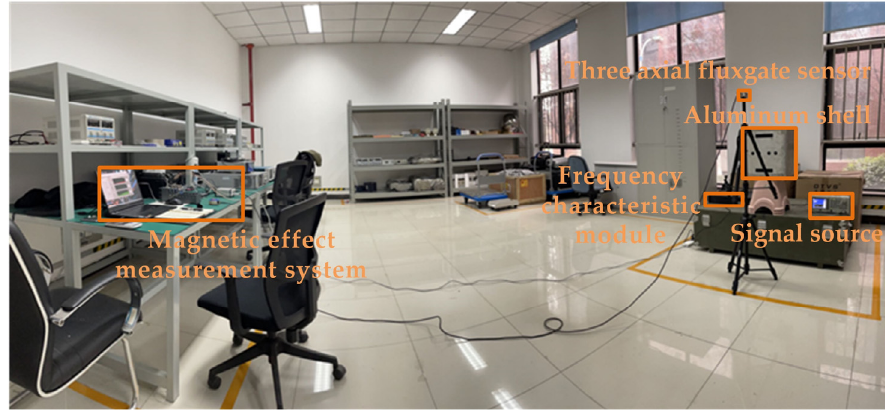
Figure 5. Test scene.